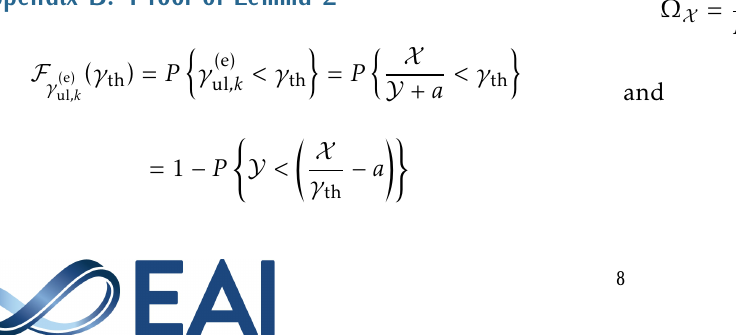
(cid:110) (cid:111) | ˜ ε | 2 By using E = β mk (cid:48) − µ mk (cid:48) and substituting mk (cid:48) (A.1), (A.2) and (A.3) into (13), the expression for achievable uplink rate is